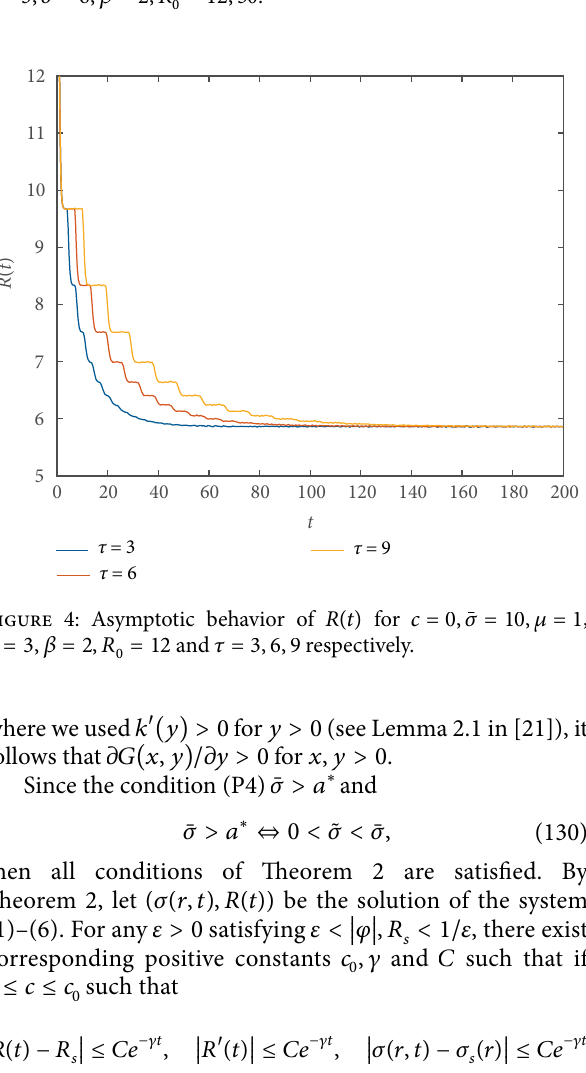
for 푐 = 0, ̄휎 = 5, 휇 = 1, 푅(푡)